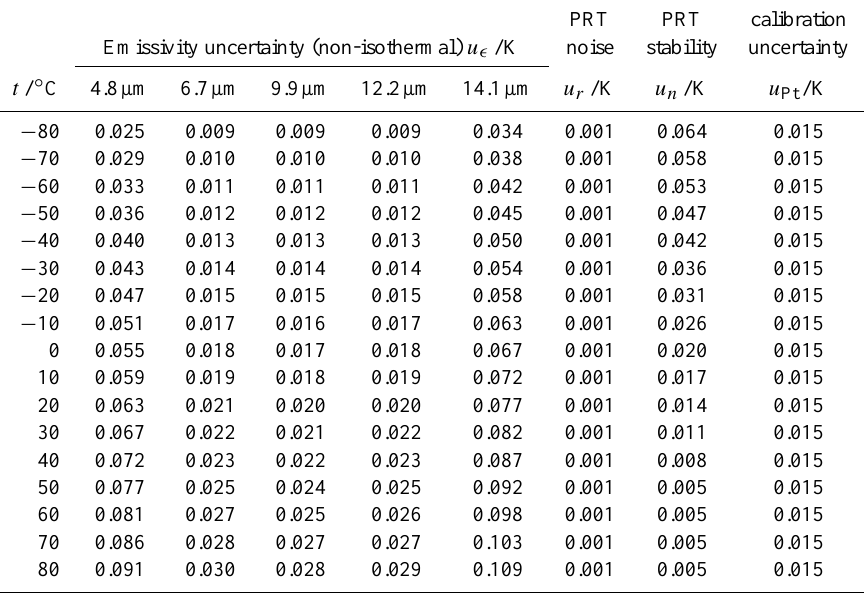
Table 2. Uncertainty components u ( k = 1) of the radiation temperature of the